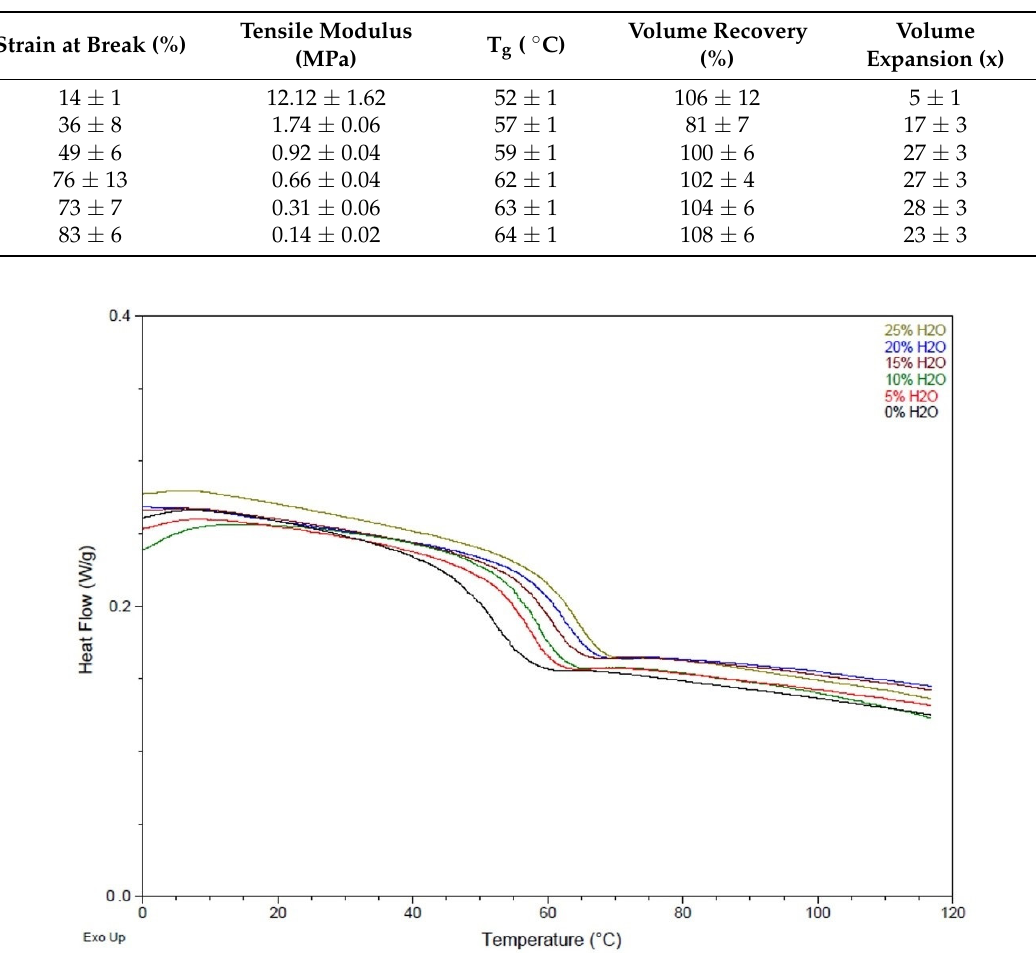
Figure 3. DSC thermograms of SMP foams with varying water content.